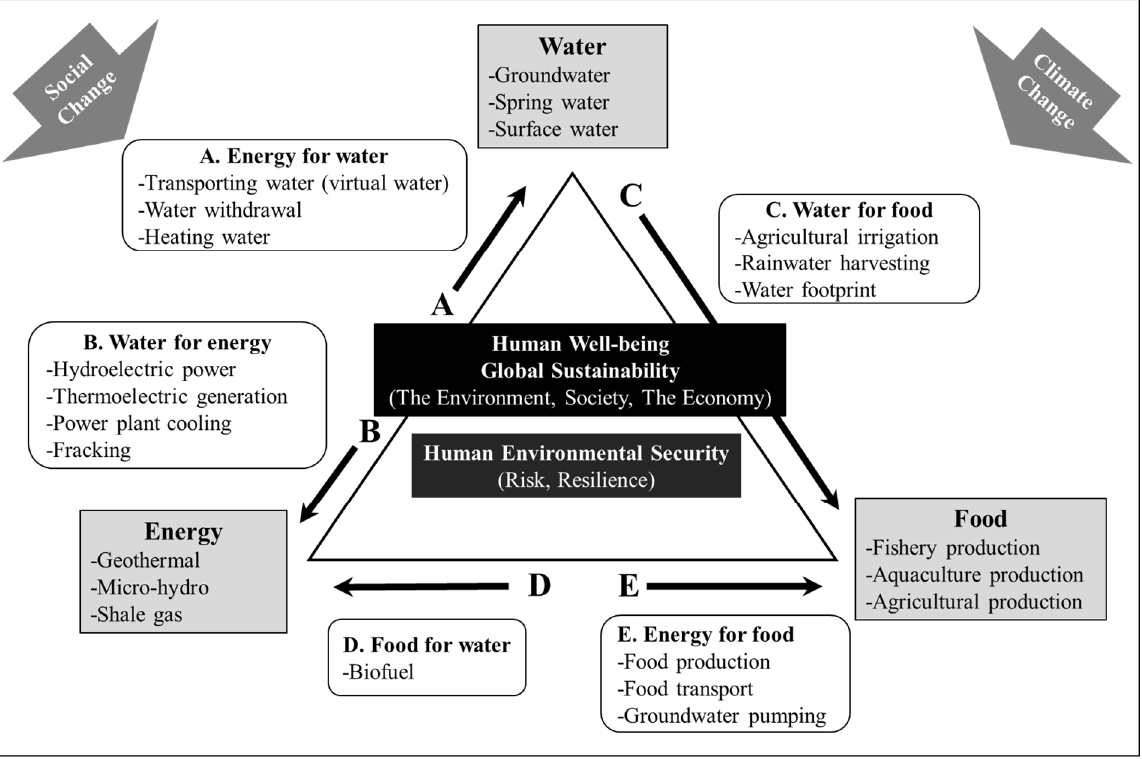
Figure 1. Dynamics of the WEF nexus under Research Institute for Humanity and Nature